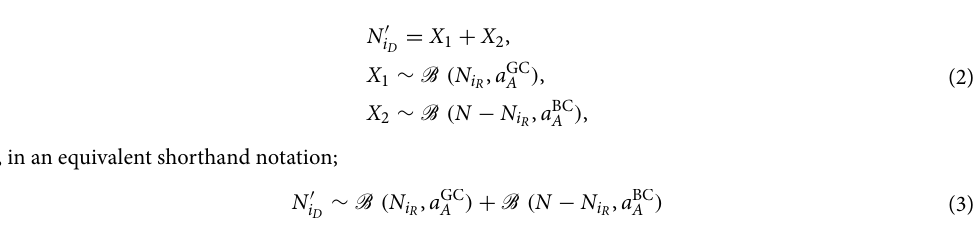
β ji Figure 2. ( A ) Reputations between all individuals. The image matrix is drawn, where each row represents { } who evaluates ( j ) and each column represents who is evaluated ( i ). Colored and uncolored dots indicate good 1 ) and bad ( β ji 0 ) reputations, respectively. From the top, each panel indicates that individuals employ ( β ji = = norms SJ, SS, SH, and SC, respectively. One might easily see the vertical stripes on the panels of SS and SC, which mean that various goodnesses coexist among individuals. For all the panels, computer simulations are 100 , e 1 0.1 . In our computer simulations, we assume that N elementary e 2 performed with parameters N = = = 100 (sufficiently long time passed). steps of updates occur per unit time. These snapshots are taken at time t = ( B ) Frequency distribution of goodness, p i , at an equilibrium calculated from computer simulation results. The horizontal and vertical axes indicate goodness p and equilibrium frequency φ ∗ ( p ) , respectively. Computer 500 , e 1 0.1 . The equilibrium frequency distribution, e 2 simulations are performed with parameters N = = = represented by colored areas in each panel, is calculated by taking the time average of 1000 snapshots during 1100 . Curves in black represent our analytical approximations using mixture Gaussian t time 101 ≤ ≤ distribution fitting (details explained in the main text), and they show excellent fits to the results of computer simulations (see insets for minor deviations). Numbers next to each peak represent labels of each Gaussian distribution, which shall be introduced later in the main